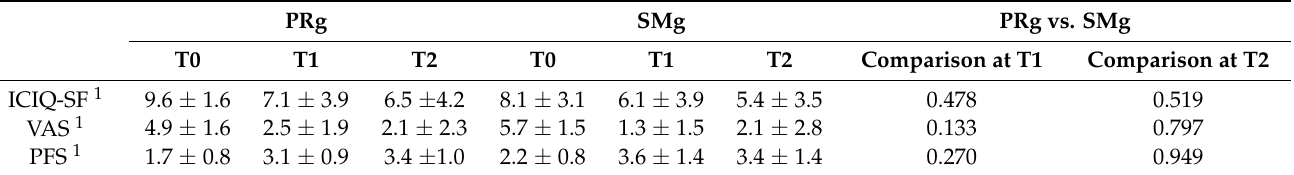
Table 4. Between-subject analysis